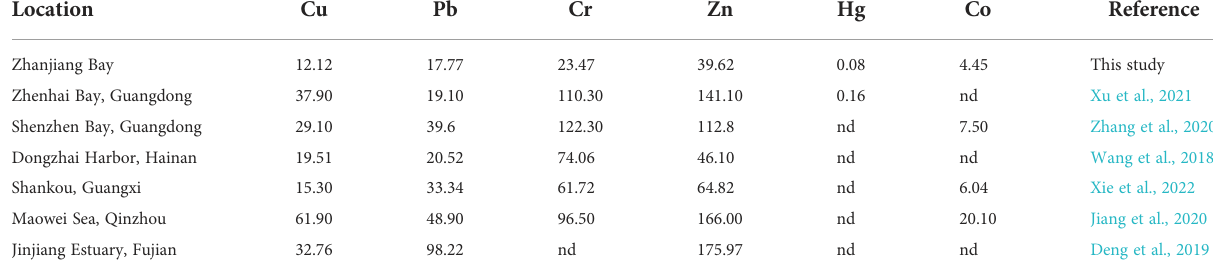
TABLE 3 Comparison of heavy metals in mangrove surface sediments in different regions of China. Location Cu Pb